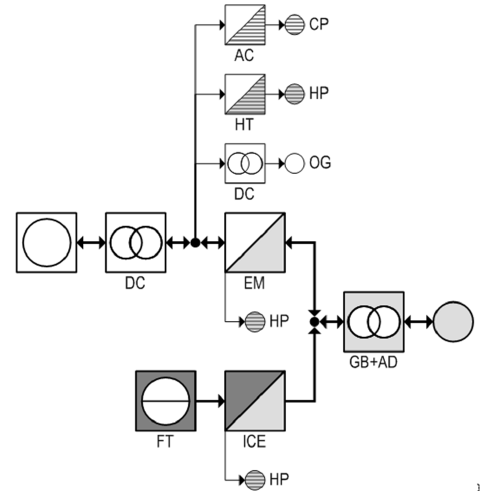
Figure 1. Simplified schematic of the parallel hybrid drive PAH. Line losses (which were taken into consideration in the simulation) are not depicted here; DP: drive power, AC: air conditioning, AT: axle drive, BT: battery, CP: cooling power, DC: DC converter, EM: electric machine, FT: fuel tank, GB: gearbox, HP: heat power, HT: heating element, ICE: internal combustion engine, OG: 14 V on-board power system.